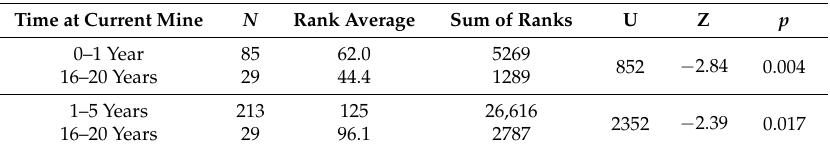
Table A4. Mann-Whitney results for mining experience and confidence in one’s ability to correctly explain or demonstrate “where your RA(s) is/are located”.